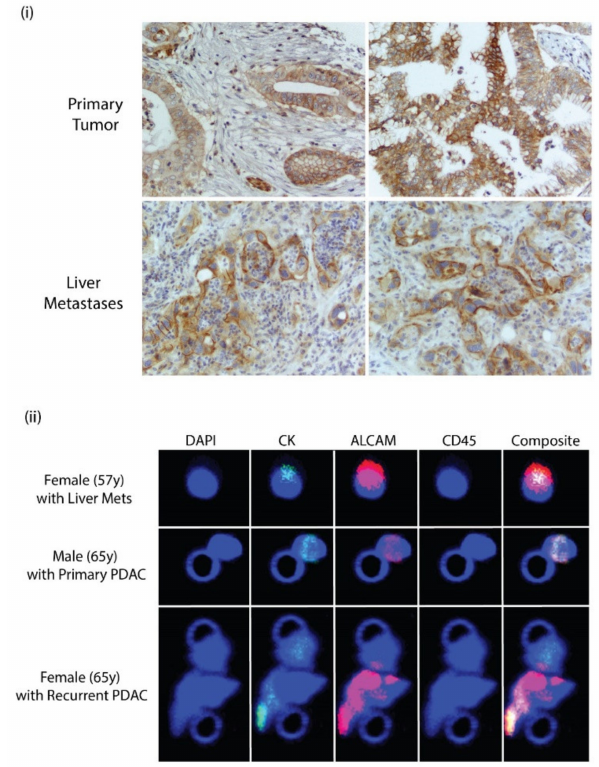
Figure 6. ( i ) ALCAM expression in human PDAC and liver metastases. ( ii ) Immunocytochemical staining of CTCs isolated from peripheral blood of patients with pancreatic cancer. CTCs were captured on Circulogix filters and stained for DAPI, cytokeratin, ALCAM, and CD45 along with a composite image of all stains. Patients were a 57-year-old female with liver mets, a 65-year-old-male with pancreatic ductal adenocarcinoma, and a 65-year-old female with a recurrent case of pancreatic ductal